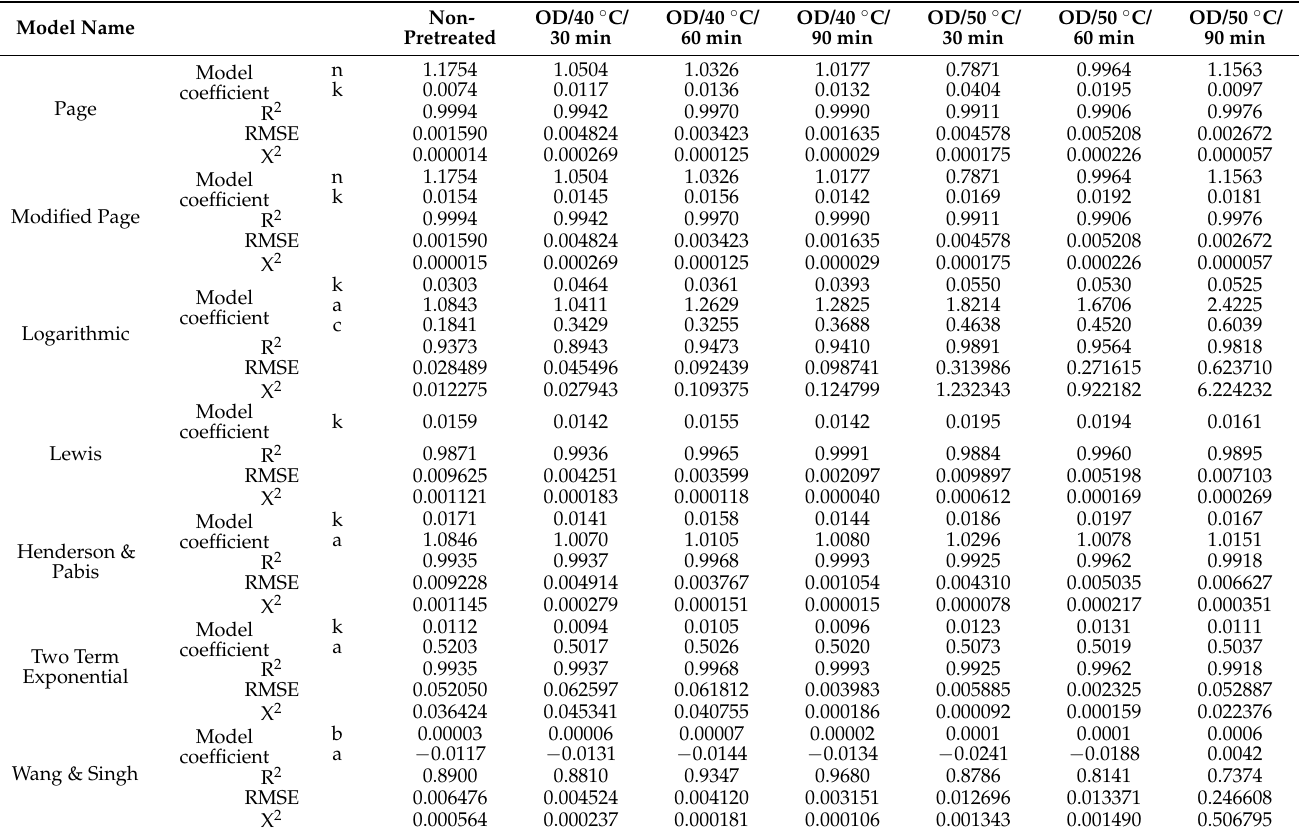
Table 1. Statistical results obtained from the modeling of kumquat